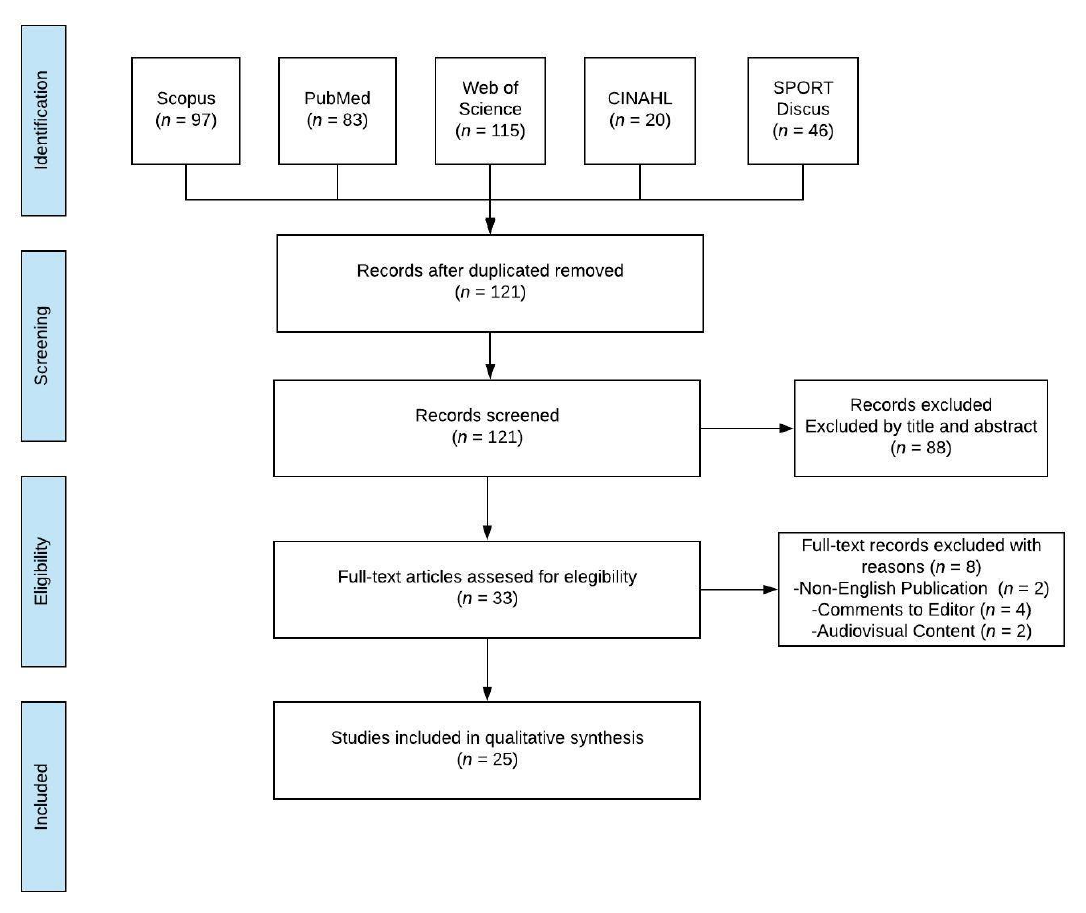
Figure1. Figure 1. Preferred Reporting Items for Systematic Reviews and Meta-Analyses (PRISMA) flow diagram.